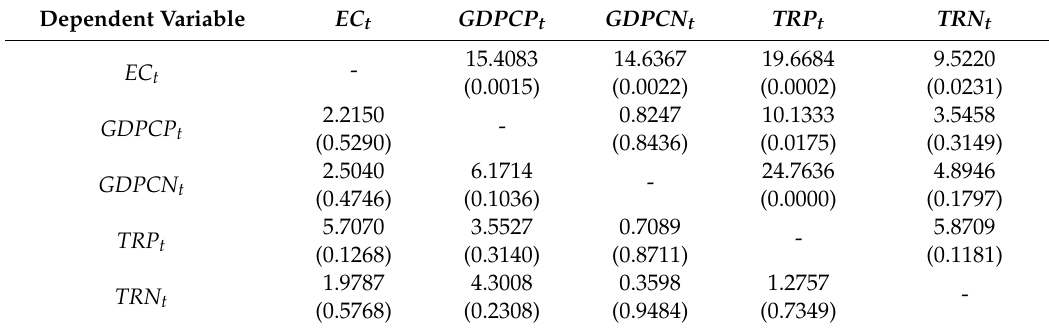
Table 4. VECM Granger